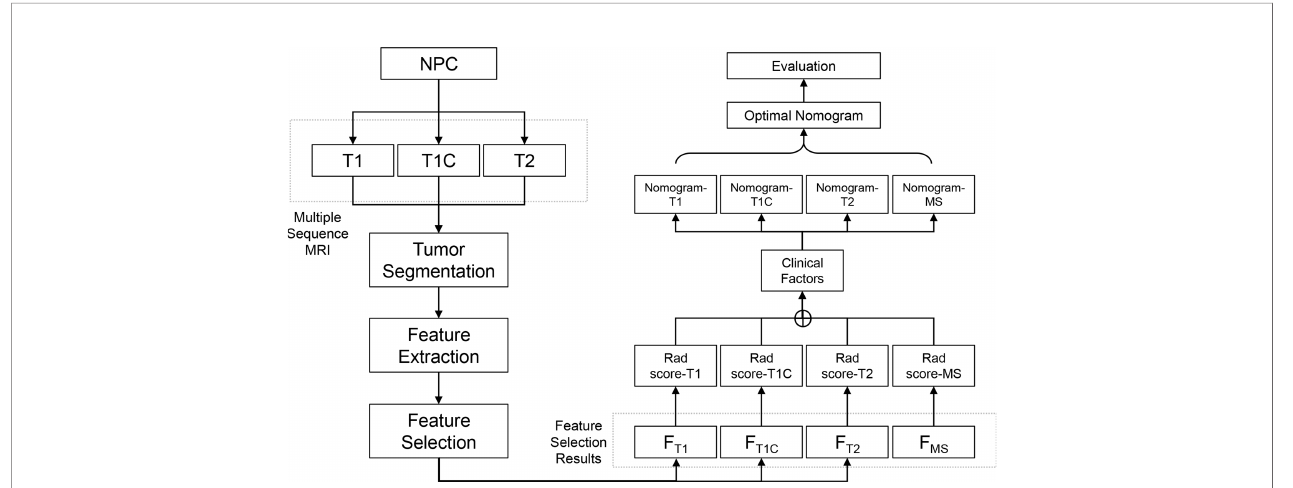
FIGURE 1 | The study design and work fl